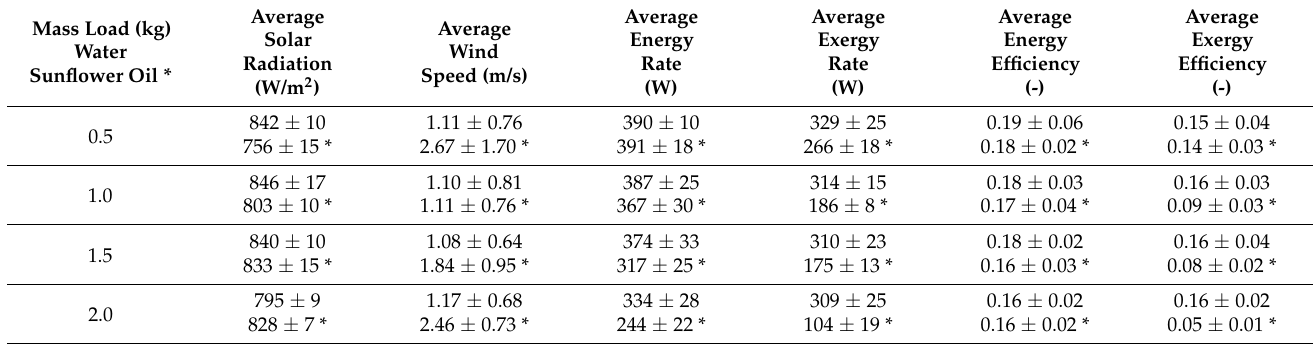
Table 2. Effect of the mass on the energetic and exergetic parameters for water and sunflower oil loads during charging cycles with 2.0